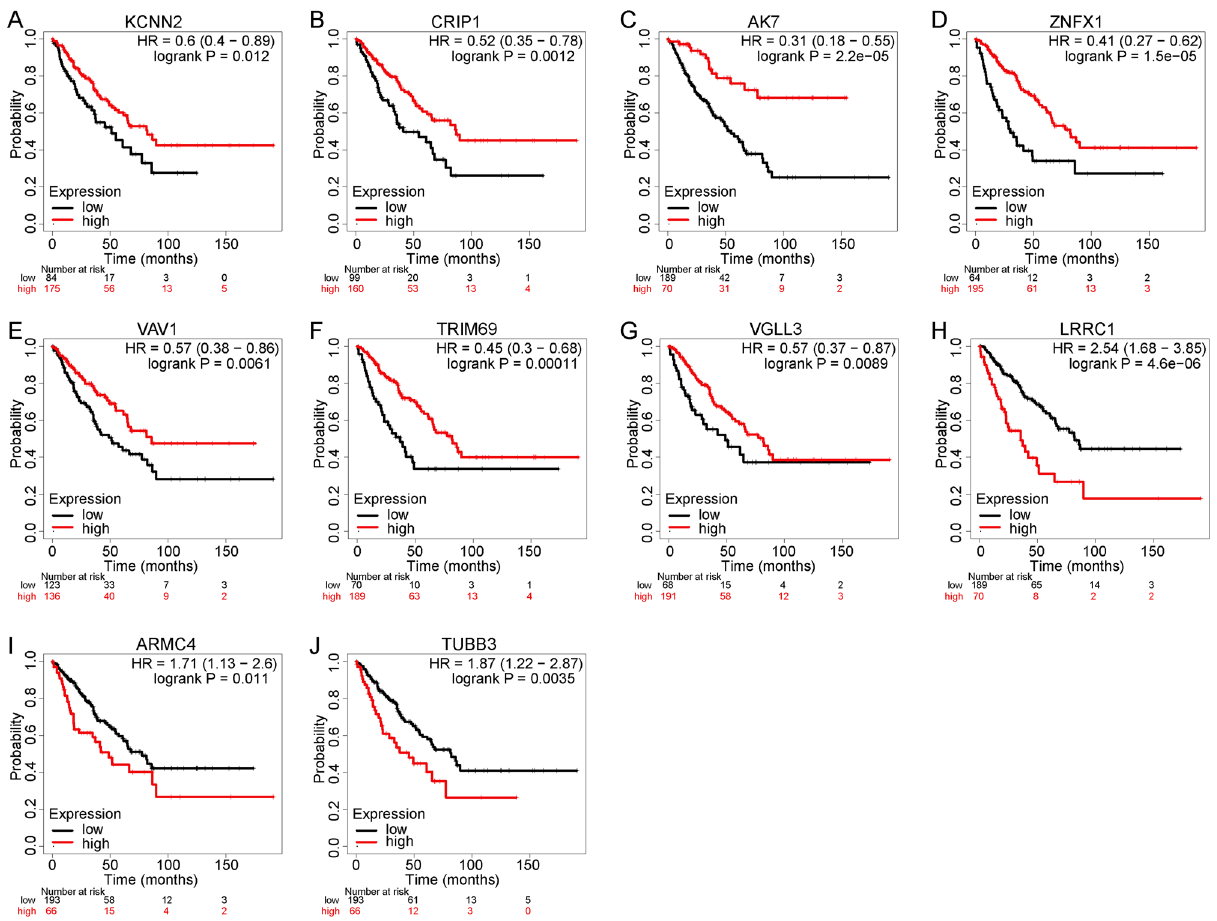
VGLL3 were significantly associated with a better overall patient survival for sarcoma. ( H – J ) The upregulated expressions of LRRC1 , ARMC4 , and TUBB3 were significantly associated with poor prognoses in sarcoma